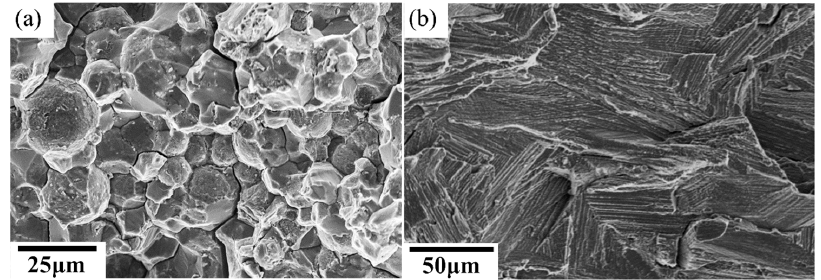
Figure 12. Creep curves of HIP + STA specimen and SLM + STA at 650 °C and 550 MPa.